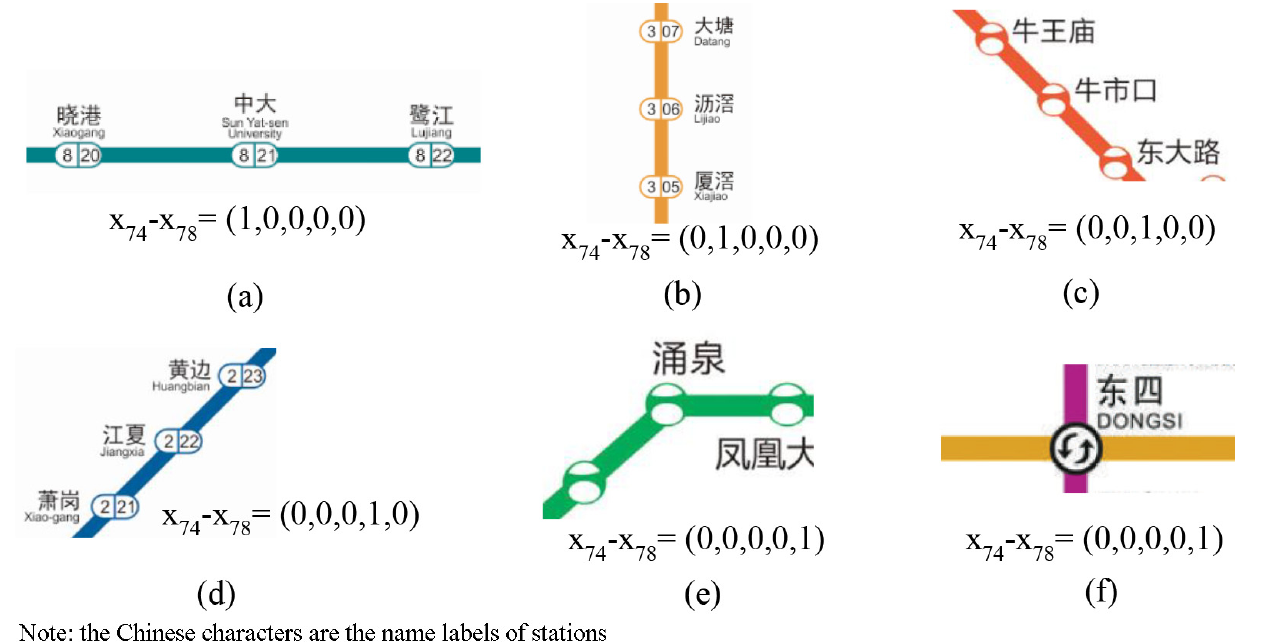
Figure 7. Five types of lines passing through name labels: ( a ) horizontal type; ( b ) vertical type; ( c ) left diagonal type; ( d ) right diagonal type; ( e ) hybrid type 1; and ( f ) hybrid type 2.